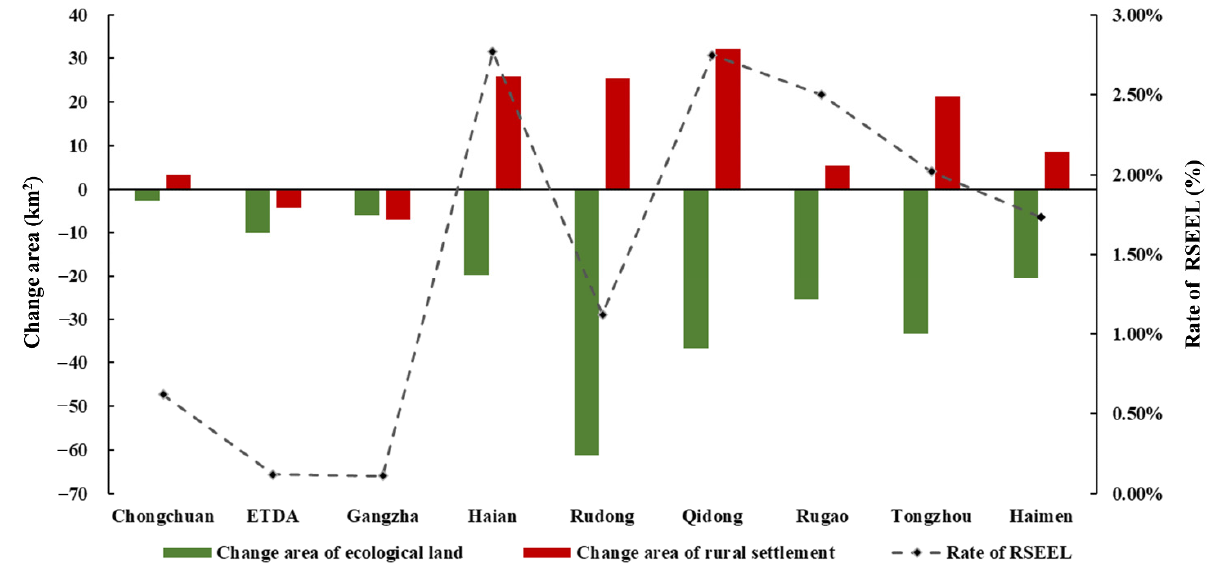
Figure 4. The rate of RSEEL and change area of ecological land and rural settlements in Nantong. (ETDA: Economic–Technological Development Area).